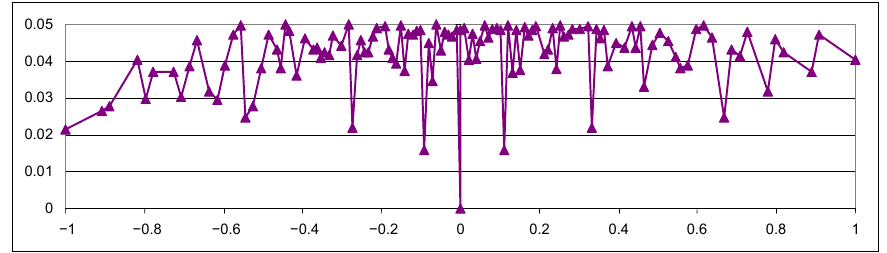
Non-CP of CIs for ER ( x / m − y / n ), as function of ER, for m = 9, n = 11, x from 0 to m , y from 0 to n group of experiment configurations when the imposed level is set to 0.05 (5%). Here, ( u , v ) sampling is ruled by bivariate binomial with the probability BS( u ; x , m + n ) · BS( v ; y , m + n ). Figure 15. CI ER,5% (0..9, 0..11, 9, 11) non-CP for m + n as common constraint as suggested in [61].